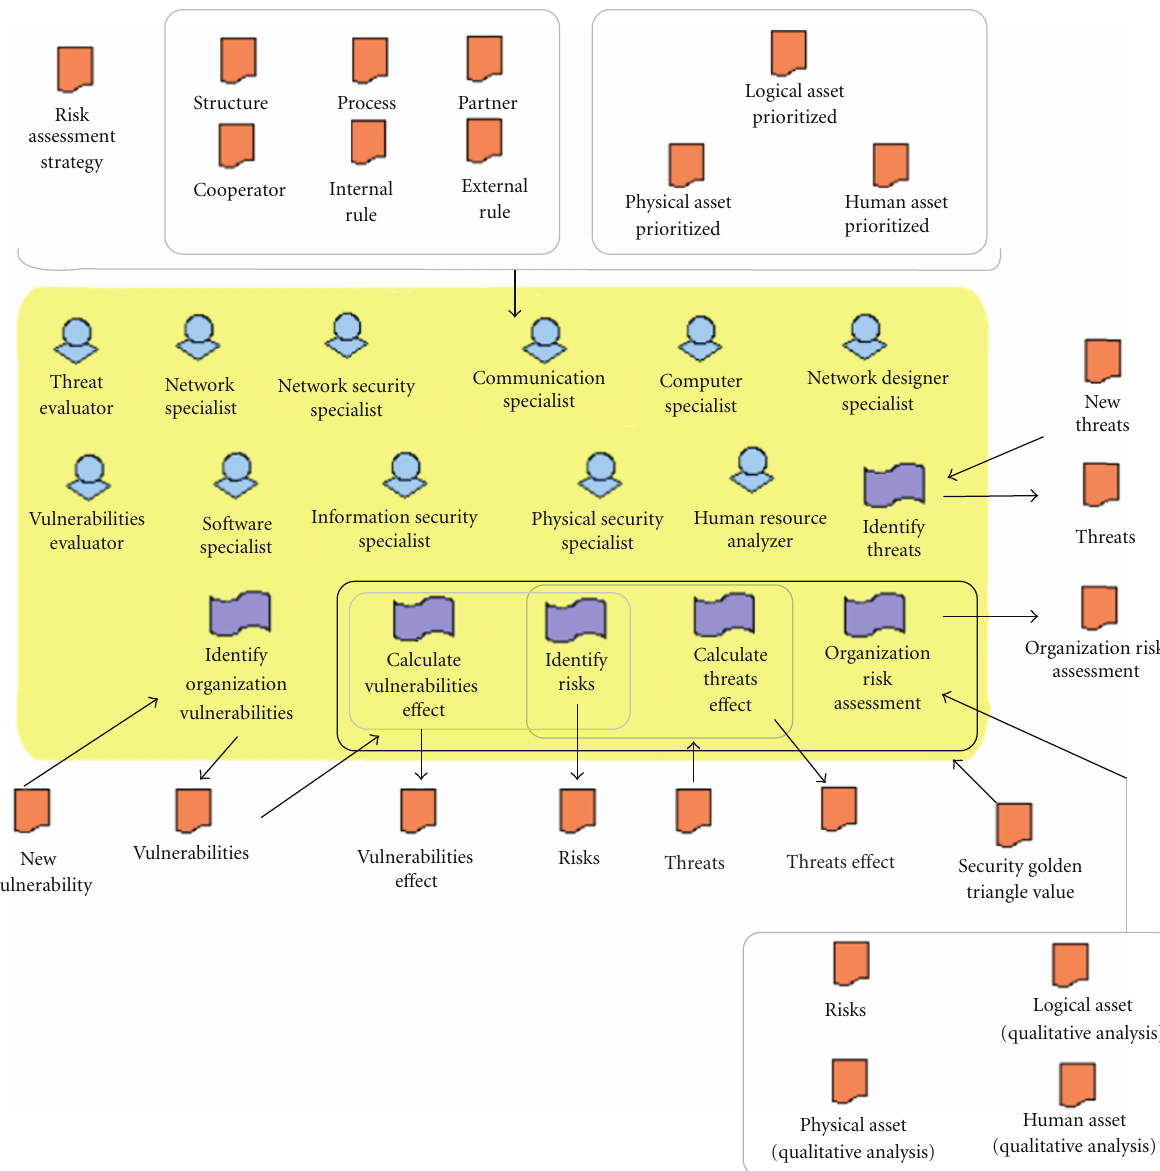
Figure 3: Identify and analyze risk workflow.